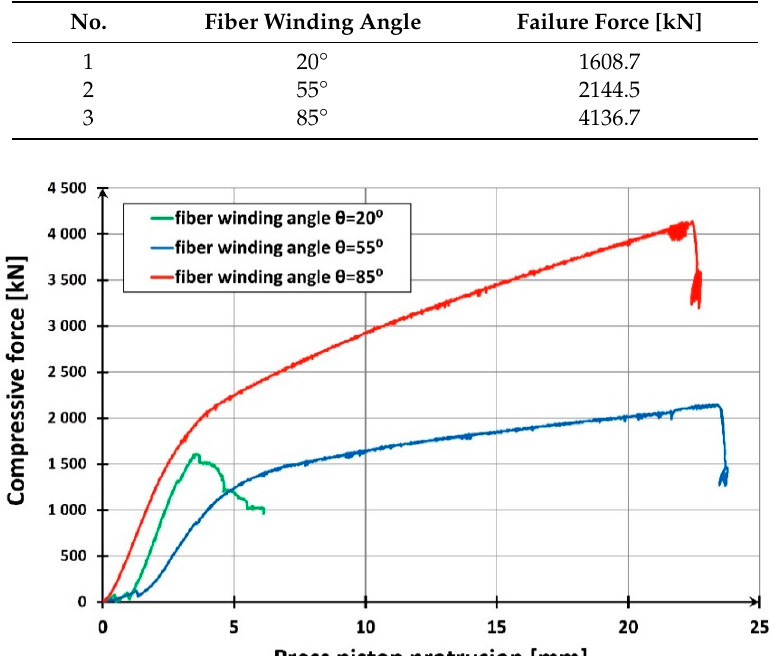
Table 5. Failure forces obtained for short concrete-filled FRP tubes (CFFT) columns depending on the angle of glass fiber winding of the composite pipe.